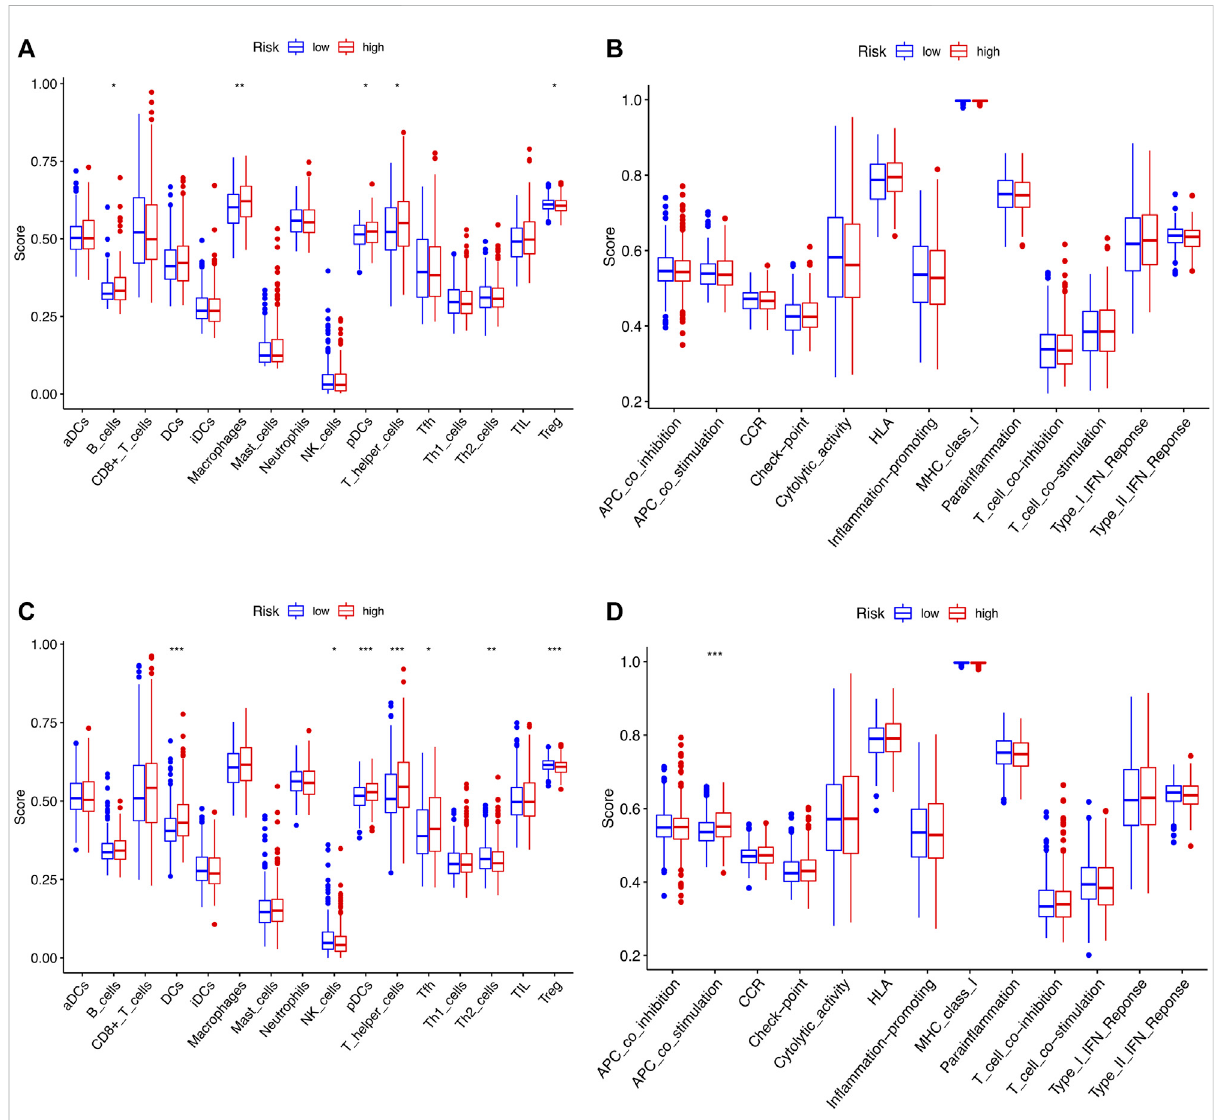
FIGURE 8 Comparison of ssGSEA scores for immune cells and immune pathways between two risk groups in the TCGA cohort and GSE39582 cohort. (A and B) The enrichment scores of 16 types of immune cells and 13 immune-related pathways between the two risk groups in the TCGA cohort. (C,D) Immune characterizations between the two risk subgroups in the GEO set. ns, p > 0.05. ns, not signi fi cant; *, p < 0.05; **, p < 0.01; ***, p <